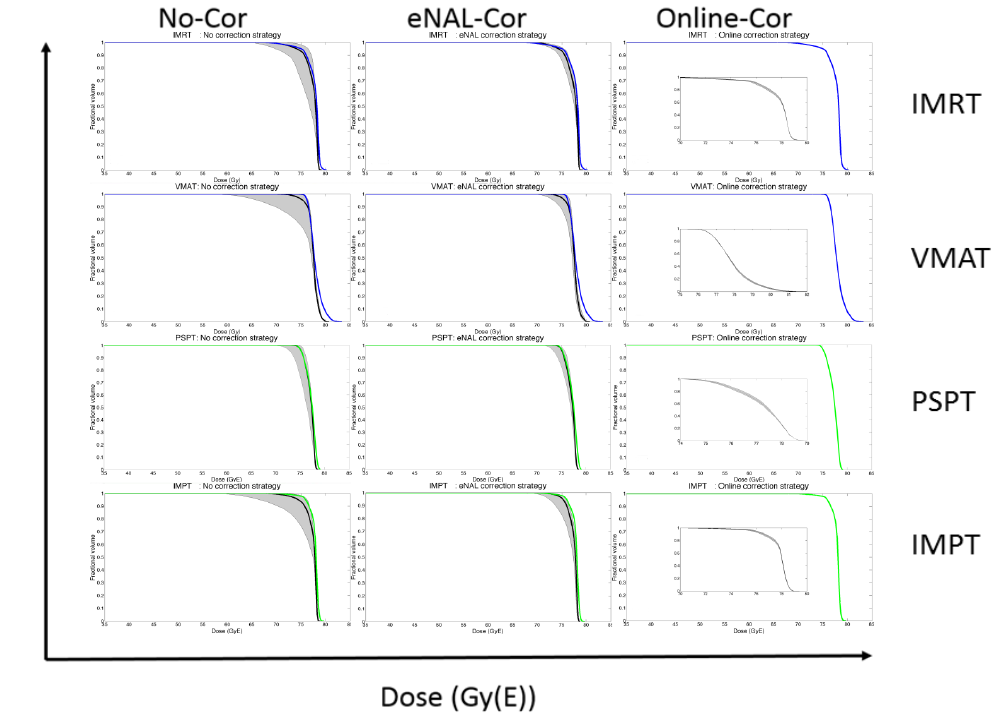
Figure 3. CTV-DVH data for an example patient for IMRT, VMAT, PSPT and IMPT with and without correction: The colored lines represent the planned treatment (blue X-EBRT, green P-EBRT). The solid black lines represent the median treatment delivered and is related to robustness which denotes the likelihood of delivering the planned dose. The shaded grey regions depict the 95% confidence intervals and are related to stability which denotes the possible range of the dose delivered. The distribution of possible treatments is asymmetric. The small figures inside the right column of the figure is a magnification of the dose-drop-off region of the